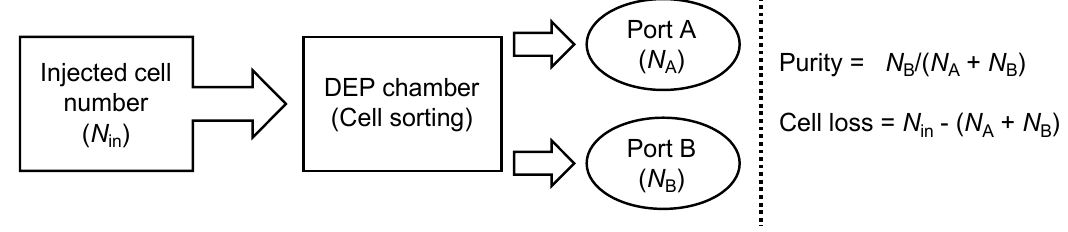
Figure 4. Evaluation of the purity of mouse ESCs and cell loss of sorted cells.